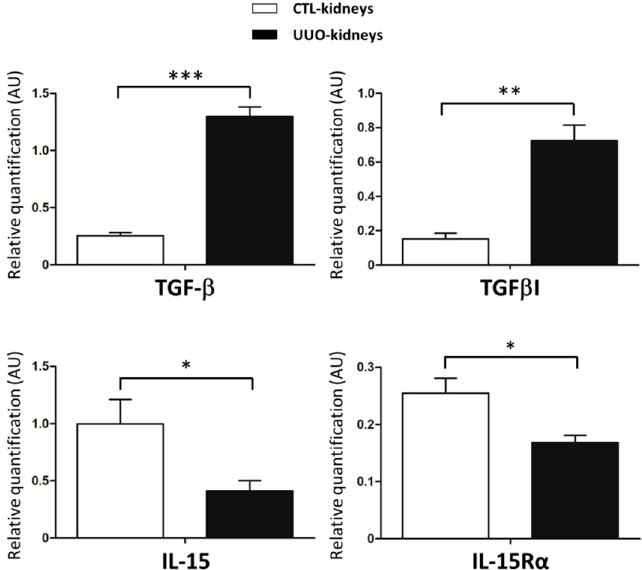
Figure 2. IL-15 expression was reduced in 8 d-post obstructed kidneys. C57BL/6 mice were subjected (black bars) or not (white bars) to UUO; kidneys were removed 8 days after surgery. Quantitative PCR analysis of IL-15, IL-15R α , TGF- β , and TGF- β I mRNA normalized to Gus B mRNA in obstructed kidneys (UUO-kidneys) and contralateral (CTL-kidneys). AU, arbitrary units. Values are means ± SEM from seven mice by group (two-way ANOVA test, * p < 0.05, ** p < 0.01, *** p < 0.001).